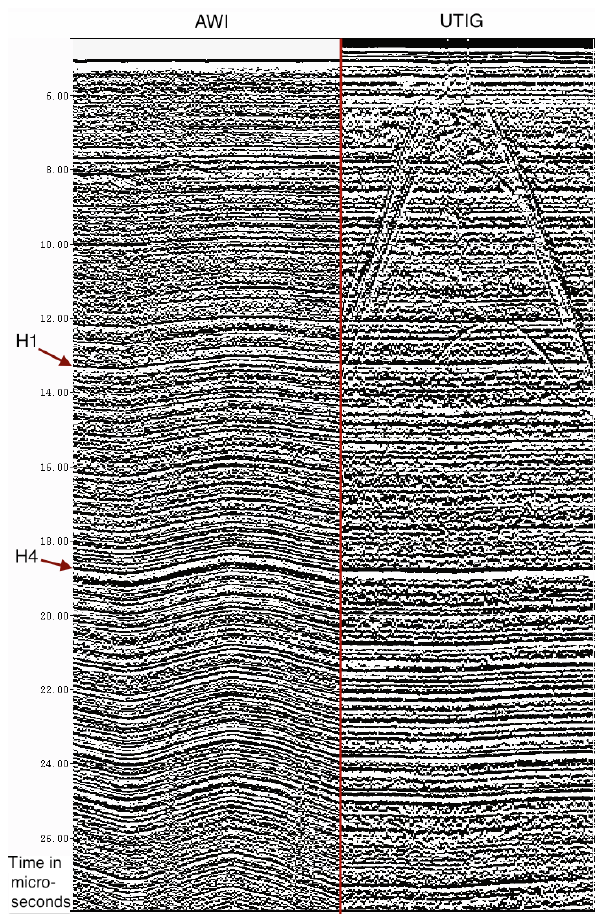
Figure 4. Intersection of AWI and UTIG profiles about 1km north- east of the drill site (see Fig. 1) for direct visual comparison. Two examples of identified IRHs are indicated by red arrows. Note that the air–ice reflection is shifted to 5µs. All strong horizons can be traced smoothly across the